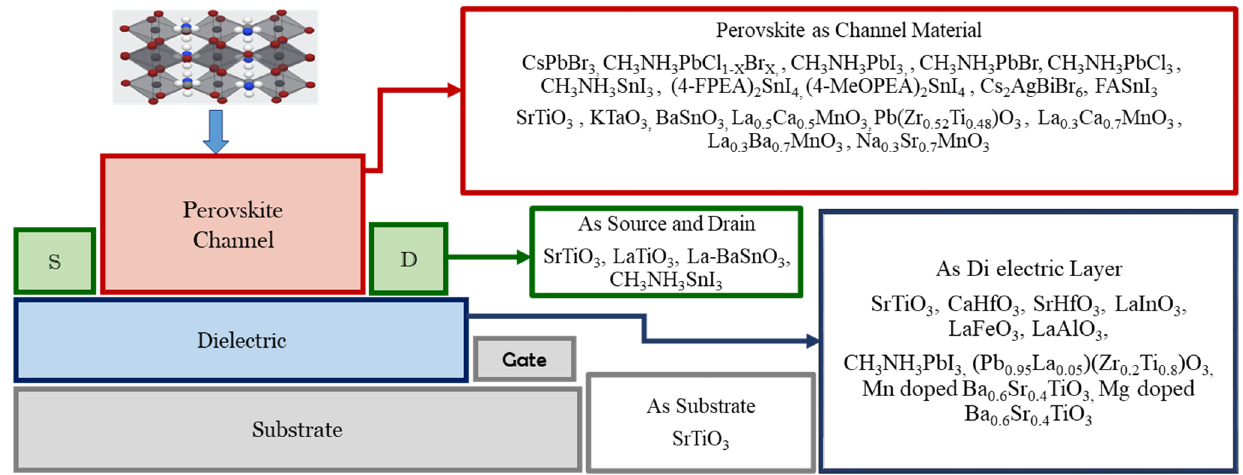
Figure 1. An enormous number of perovskite materials are being used to perform different functions in the thin-film FET literature.